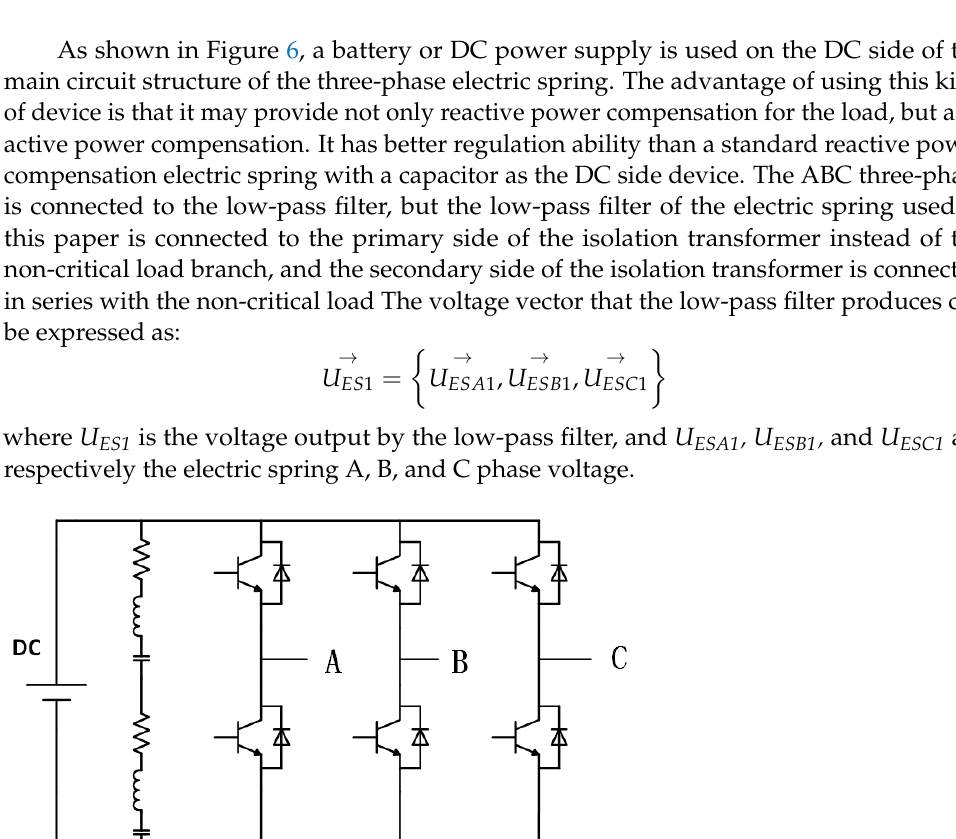
Figure 7. Decoupling control strategy of electric spring.